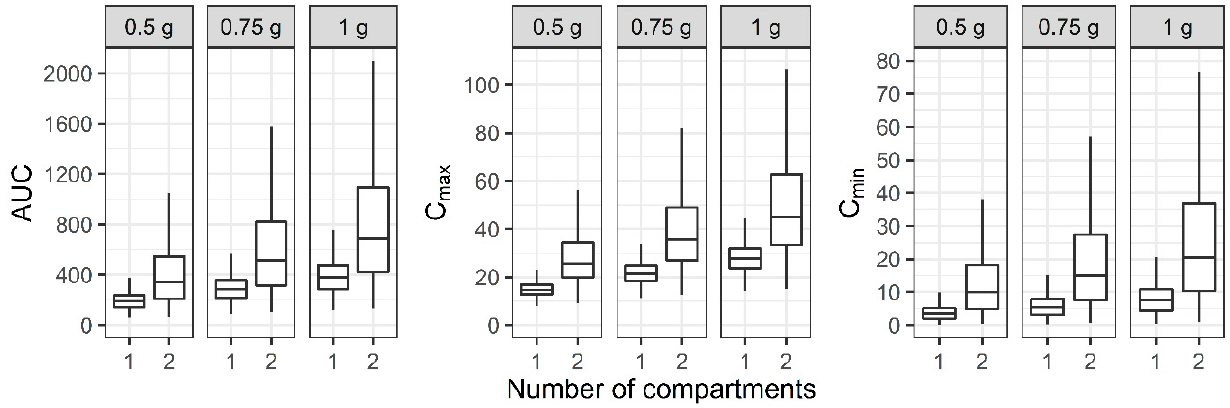
Figure 4. Distribution of area under the curve over 24 h (AUC), maximum concentration (C max ), and minimum concentration (C min ) at steady state when one- and two-compartment models were developed with two-compartment PK profile and sparse or dense sampling designs (dashed lines, typical parameter values used for simulation; horizontal line inside the box, median; ends of each box, upper and lower quartiles; whiskers, 1.5 × quartiles). For the two-compartment PK profile, the probability of an AUC/MIC of <400 for the reduced one-compartment model was 86.3% when a regimen of 0.75 g IV infusion over 2 h every 12 h was administered and the MIC was 1 mg/L, while the probability for the two-compartment model was 36.3%. In the case of an AUC/MIC of 400 to 600, which considers efficacy and safety simultaneously, the PTA for the one-compartment model with the same regimen was 13.5%, while the PTA for the two-compartment model was 22.6%. The probability of an AUC/MIC of >600 for the one-compartment model was 0.120%, while that for the two-compartment model was 41.1% when vancomycin was administered with the same dosage regimen (Table 3). Table 3. Probability (%) for three PK/PD parameters of vancomycin when one- and two-compart- ment models were developed with 10,000 two-compartment PK profiles and sparse or dense sam- pling designs.